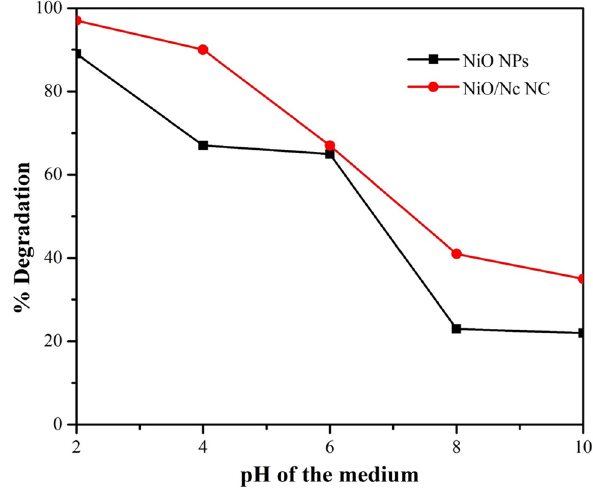
Fig. 11 %degradation of O II dye by NiO NPs and NiO/Nc NC pho- todegraded in different pH